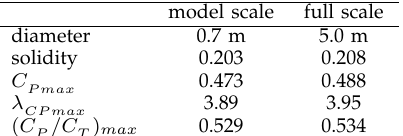
Fig. 26. Full-scale turbine geometry, λ des = 3 . 5 : front and side views (counter-clockwise rotating turbine). Next, the effect on performance and operating con- ditions of results obtained at different λ des is analyzed in Figs. 27 to 28. Specifically, three alternative design solutions corresponding to λ des = 3 . 5 , 5 . 0 , 6 . 8 are